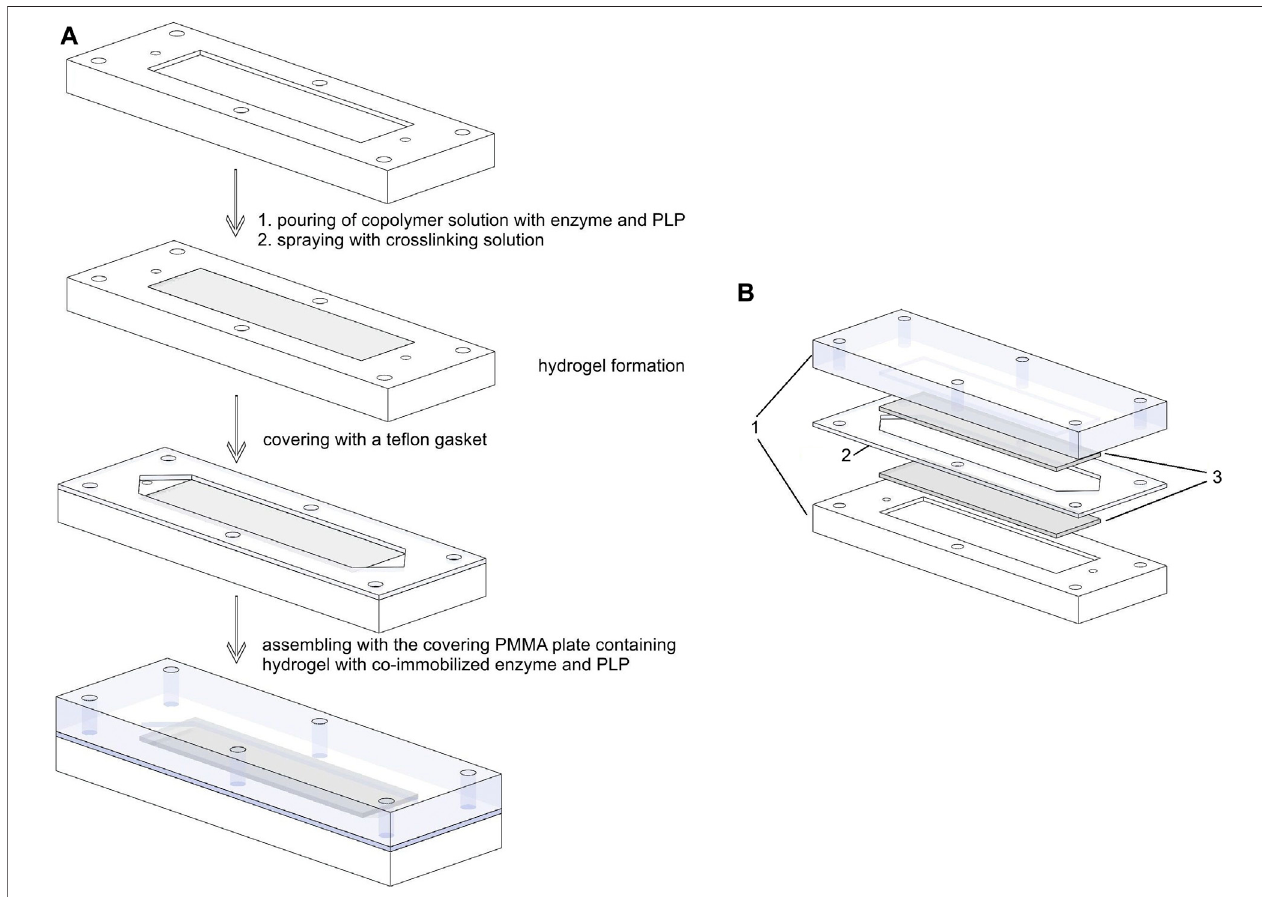
FIGURE1| Schematicpresentationof (A) immobilizationprocedureandassemblyofamicrobioreactorbetweentwoplates; (B) explodedviewofafullyassembled microbioreactor: 1-PMMA plates; 2- PTFE gasket; 3-hydrogel layers with co-immobilized enzyme and PLP.